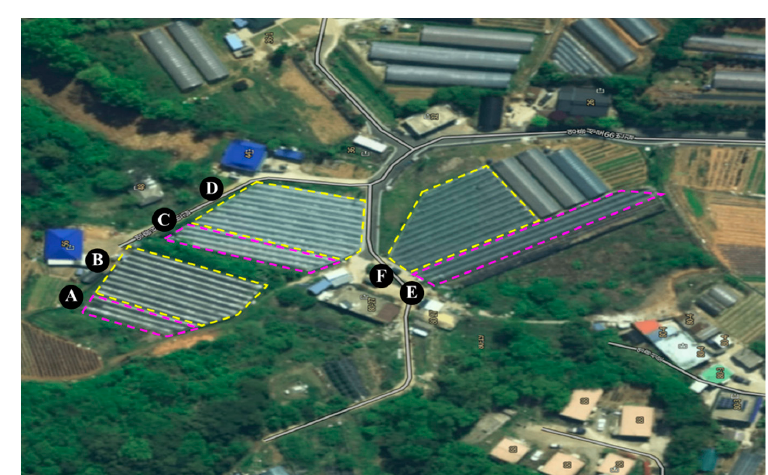
Figure 5. Aerial photo of 3 types of installed panels. Energies 2020 , 13 , x FOR PEER REVIEW